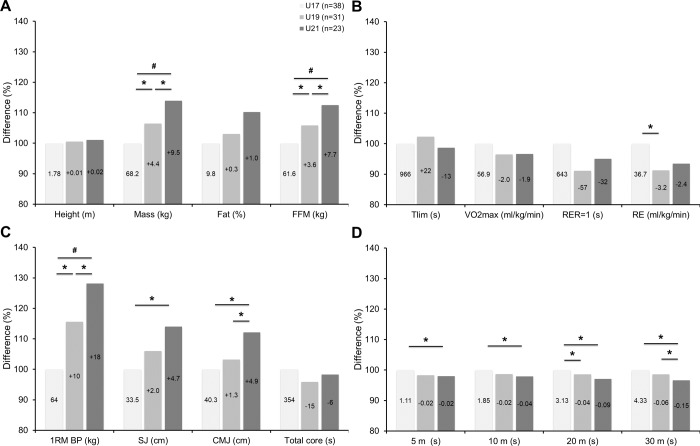
Differences in anthropometric characteristics (A) and physical capacities (B-D) between U17, U19, and U21 years old elite junior soccer players. Bars show relative differences in relation to U17 players. Within bars, absolute data and differences in relation to U17 players are also shown. U17, U19, and U21 = Under 17, 19, and 21 years old players; n = Sample size; FFM = Fat-free mass; Tlim = Time to exhaustion; VO2max = Maximum oxygen uptake; RER = Respiratory exchange ratio; RE = Running economy; 1RM = One repetition maximum; BP = Bench press; SJ = Squat jump; CMJ = Counter movement jump; * = Moderate effect size; # = Large effect size.